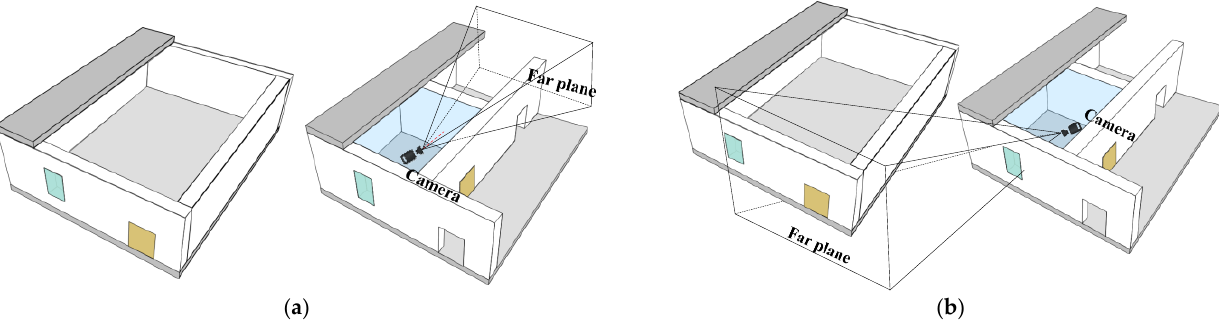
Figure 5. Semantic-based scheduling algorithm for outdoor scenes. Scheme to ( a ) remove outdoor Building Information Modeling (BIM) models and ( b ) load outdoor BIM models. Algorithm 2. Semantic-based scheduling algorithm for indoor scenes